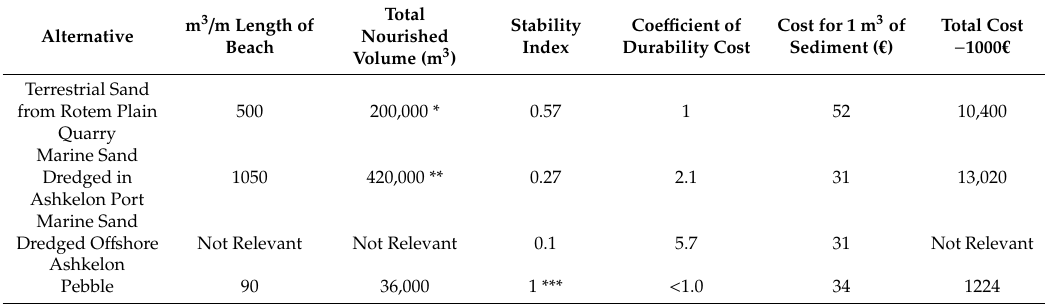
Table 2. Costs of alternatives for nourished imported sediment for Tel Ashkelon